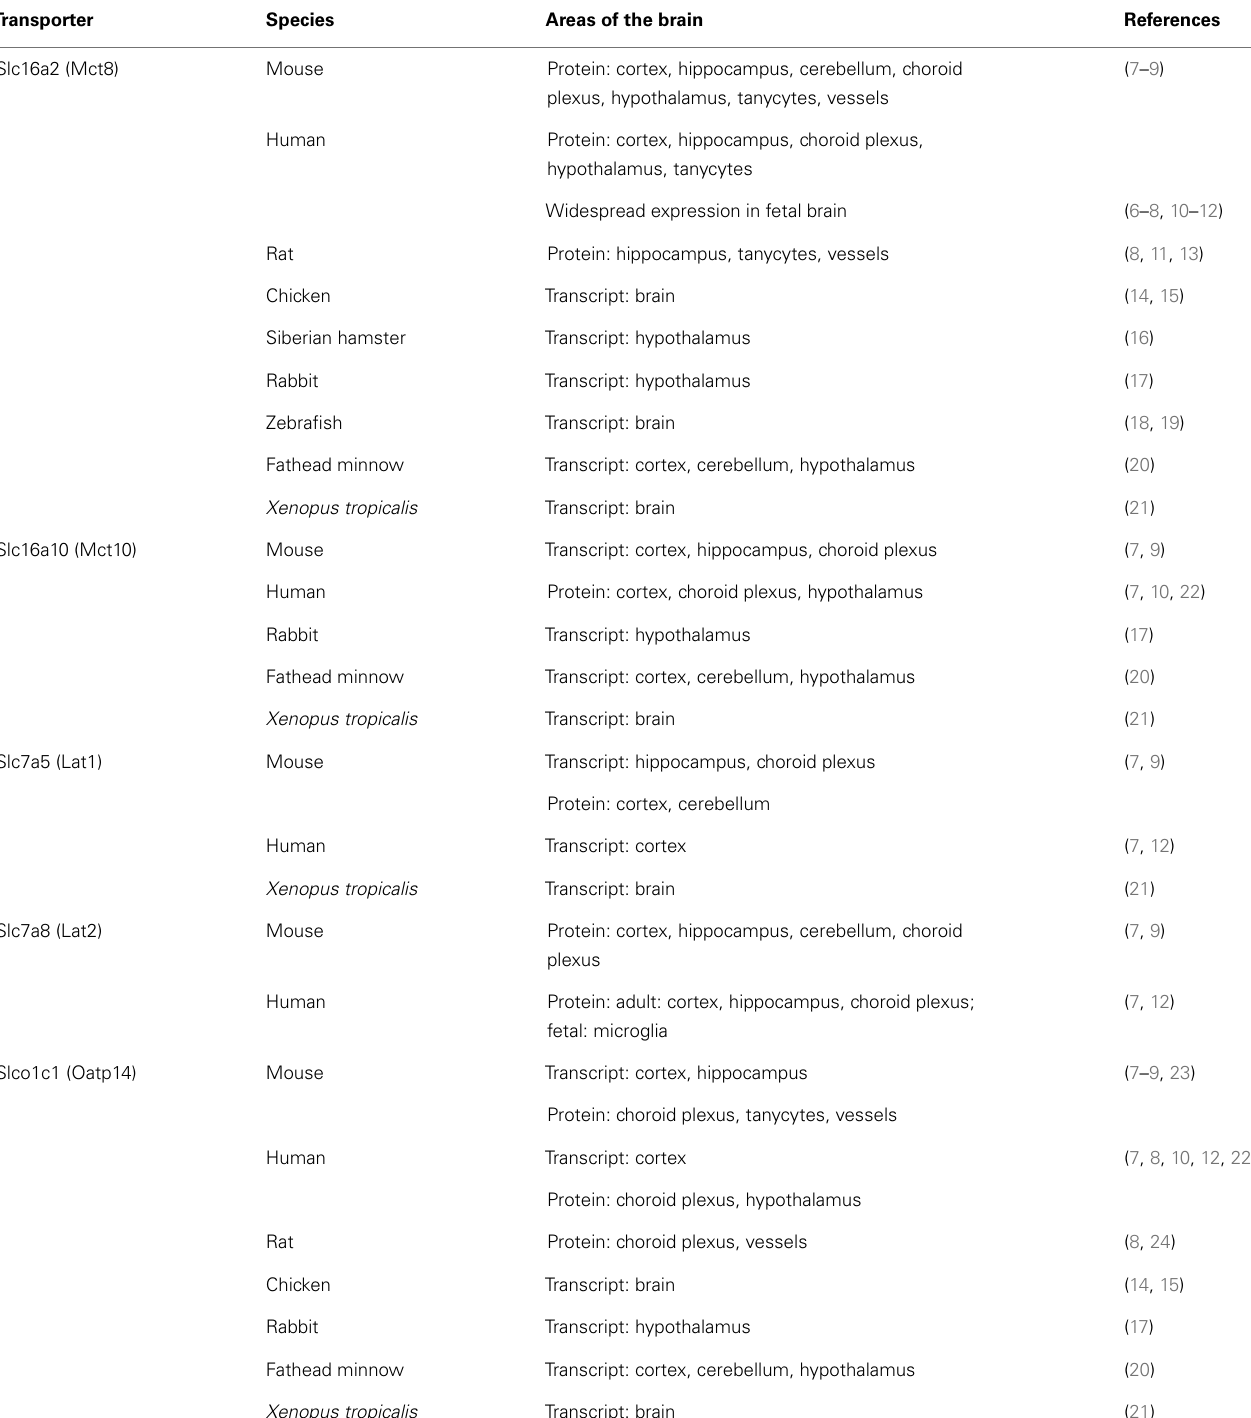
Table 1 | Summary of expression profiles of thyroid hormone transmembrane transporters (THTT) in various cell types of the brain of several species